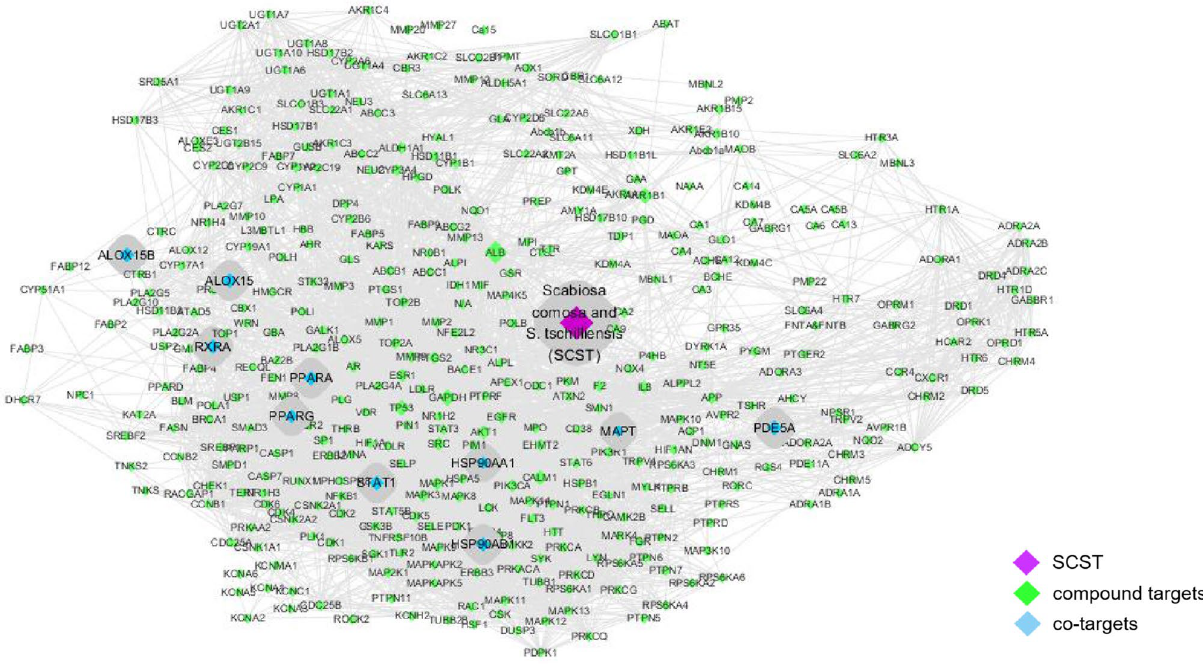
Figure 1. The network of SCST "compounds-targets-interacting proteins". The purple nodes represent SCST, the green nodes represent compound targets, and the blue nodes represent